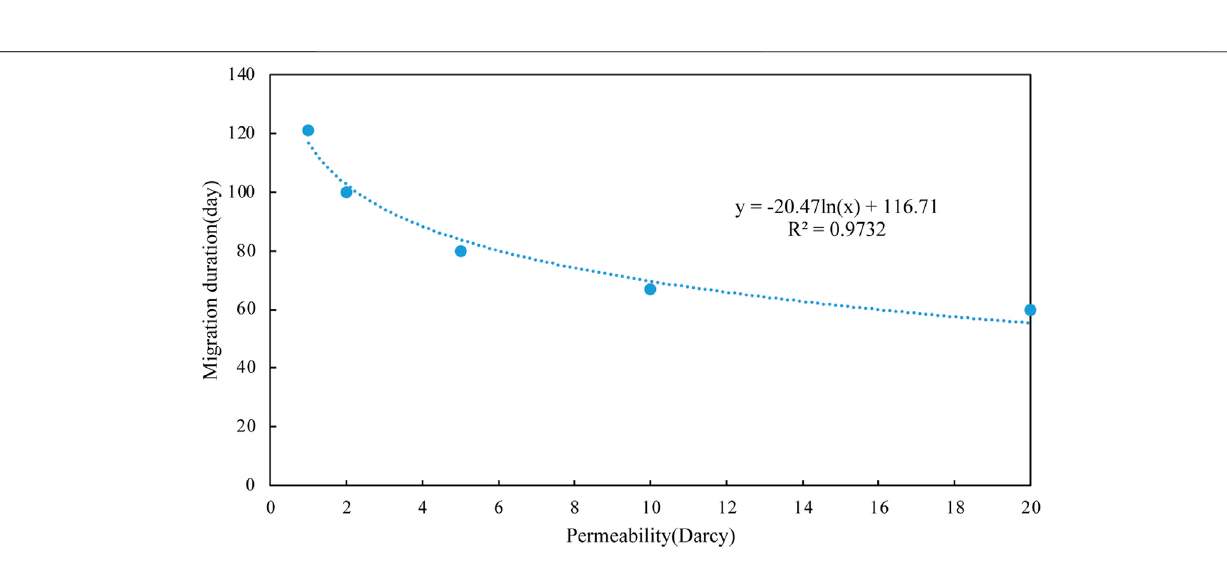
Frontiers in Earth Science |